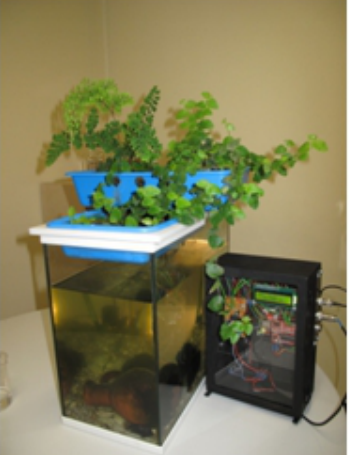
Figure 16. Photo of the assembled system